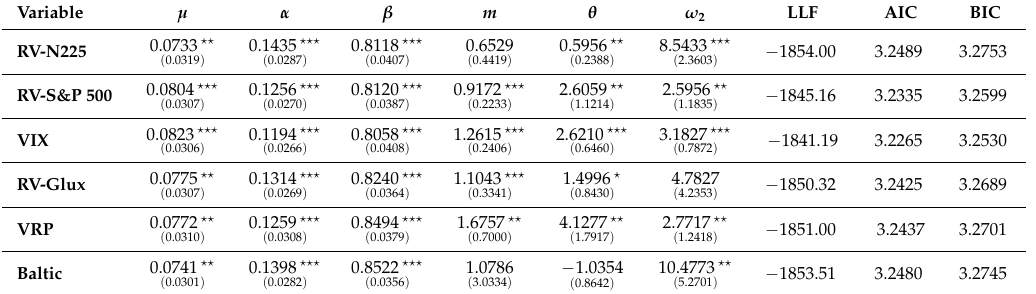
Table 5. GARCH-MIDAS for Nikkei